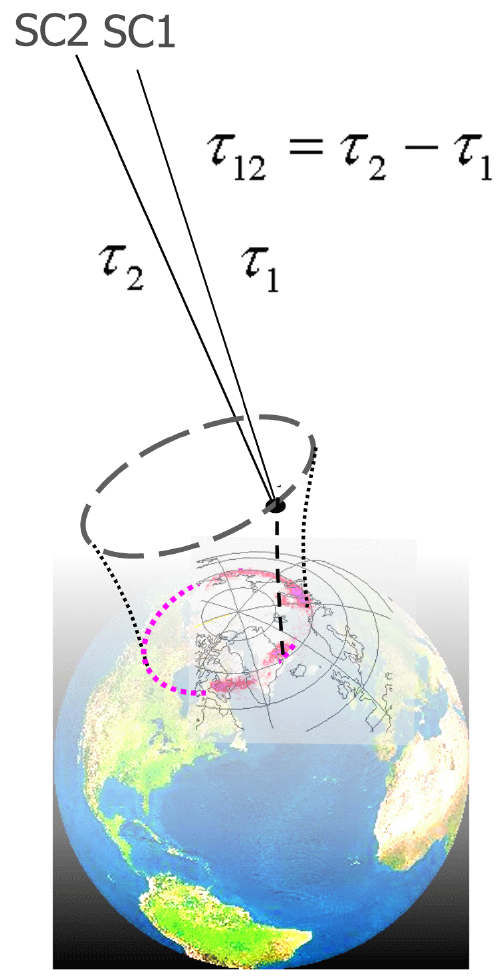
Fig. 15. Geometry of AKR source location scheme. The source is constrained to locations in a ring 1.8 R E from the Earth’s center and projected outward along magnetic field lines traversing the auroral oval imaged at the time of the observed AKR